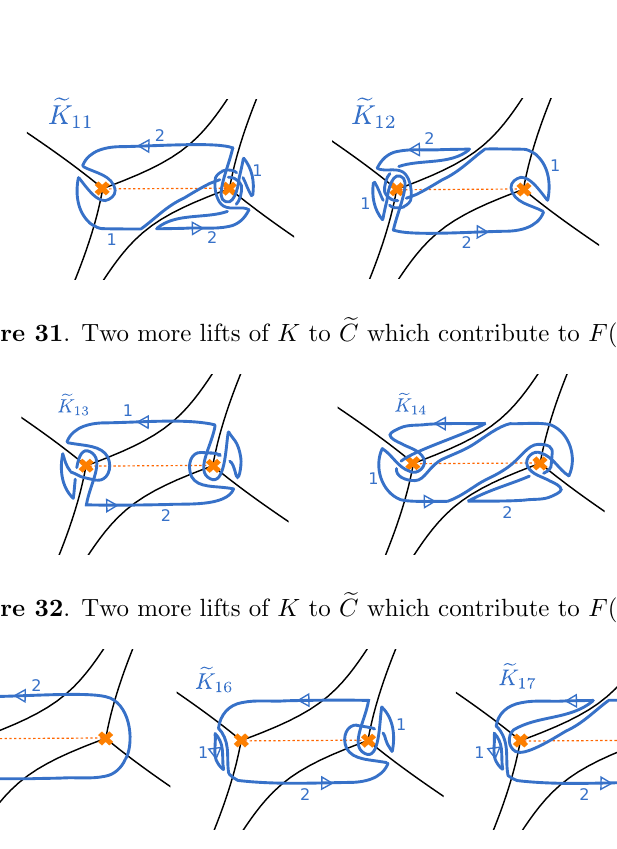
Figure 33 . Three more lifts of K to e C which contribute to F ([ K ]).